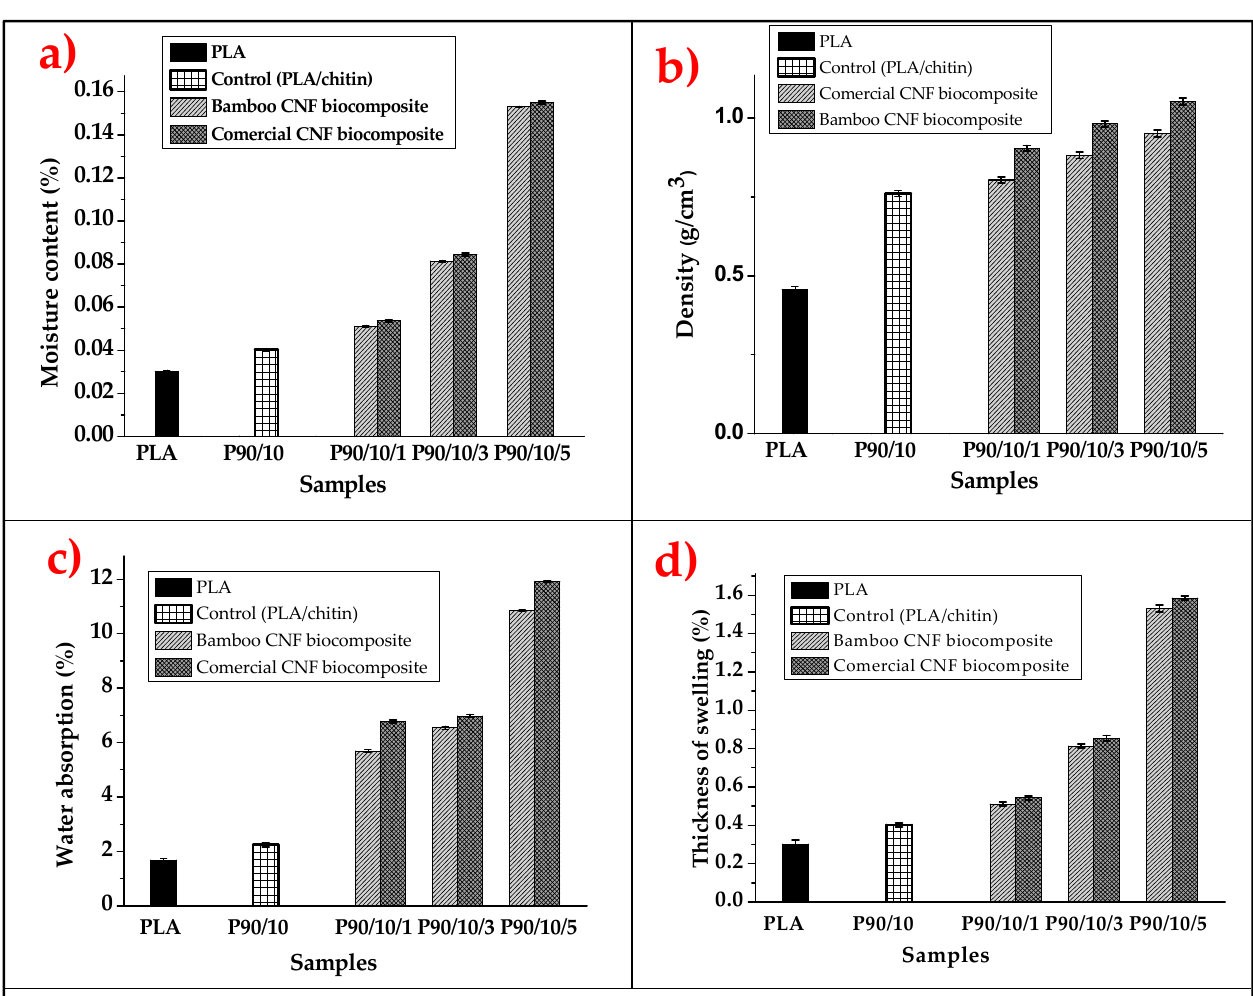
Figure 3. ( a ) Moisture content; ( b ) density; ( c ) water absorption; ( d ) swelling thickness properties of bamboo and commercial CNF ‐ reinforced PLA/chitin.